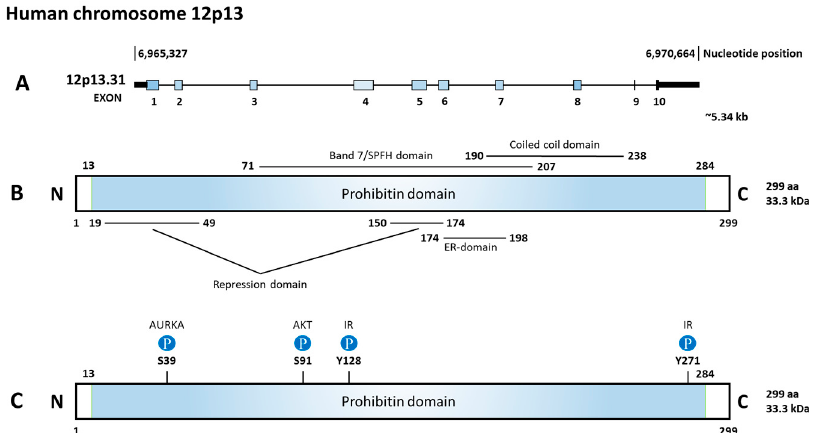
Figure 2. Diagram of gene, function domains, and phosphorylation sites of prohibitin 2 (PHB2). ( A ) PHB2 is located on chromosome 12p13.31, consisting of 10 exons. ( B ) The prohibitin domain locates from 13aa to 284aa. Inside the prohibitin domain, there are two repression domains, a Band7/SPFH domain, a coiled coil domain, and an estrogen receptor (ER)-domain. ( C ) Upstream regulators and the phosphorylated site on PHB2. Aurora kinase A (AURKA) phosphorylates S39, AKT serine/threonine kinase (AKT) phosphorylates S91, and insulin receptor kinase (IR) phosphorylates Y128 and Y271.